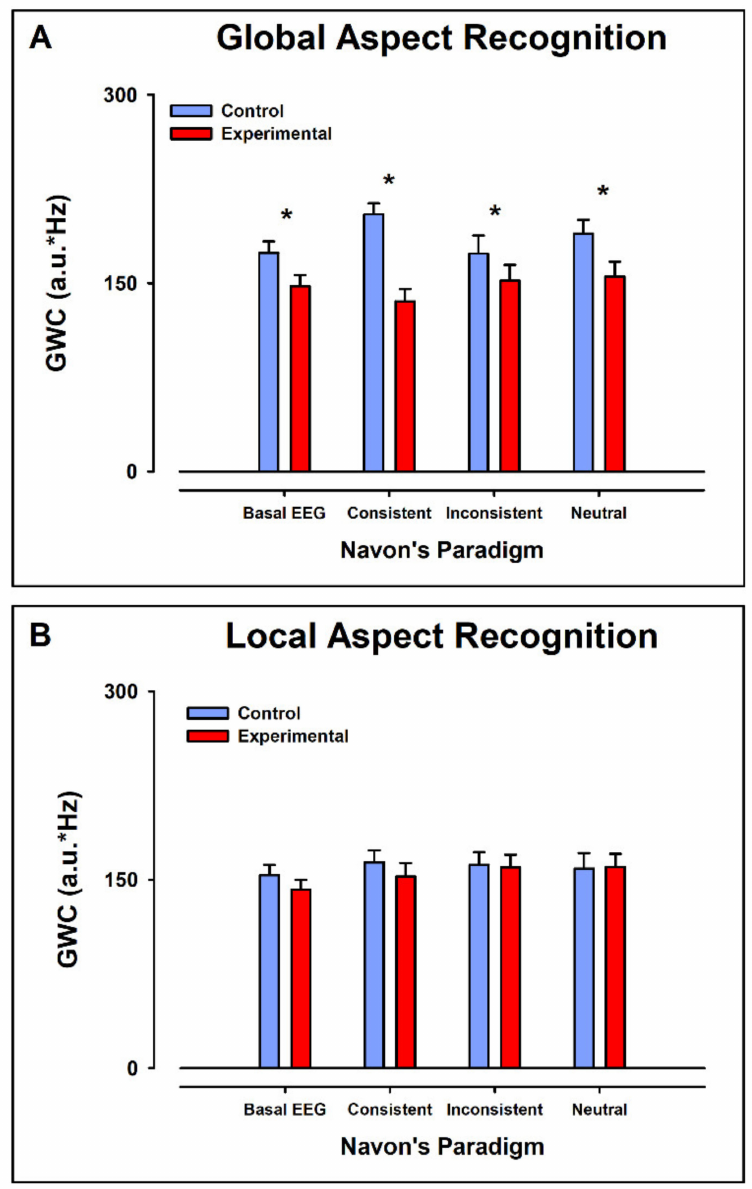
Figure 3. Comparison of the average Global Mean-Weighted Coherence (GMWC) obtained from control and experimental group. ( A ) GMWC for Global Aspect Recognition. ( B ) GMWC for Local Aspect Recognition. In ( A , B ), the basal EEG activity, consistent, inconsistent, and neutral conditions are displayed. Note that in A, there was a significant difference in the GMWC between the control group and the experimental group in all conditions. p < 0.05 is marked with